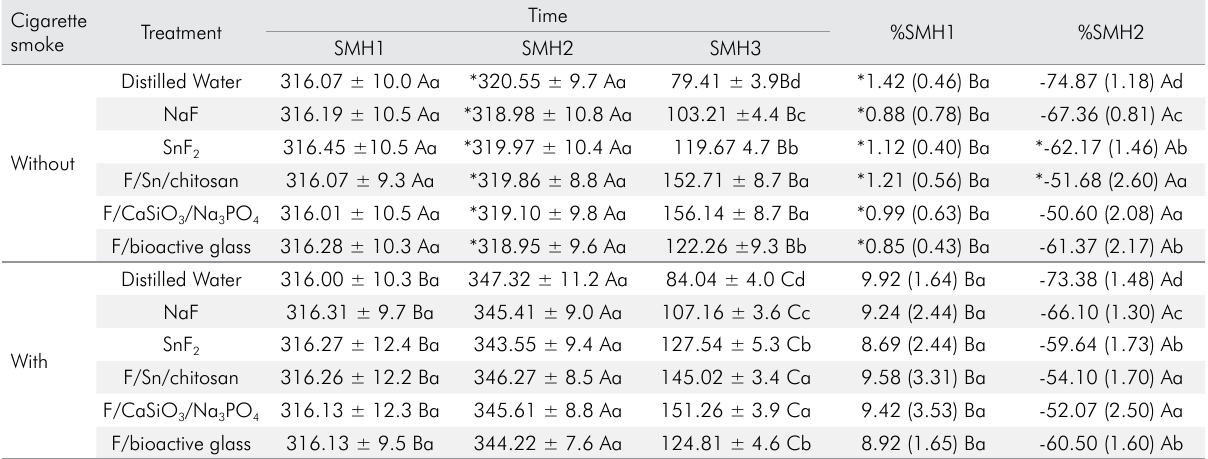
Table 2. Results (mean ± standard deviation) of surface microhardness (SMH) and %SMH based on treatment and time. Cigarette